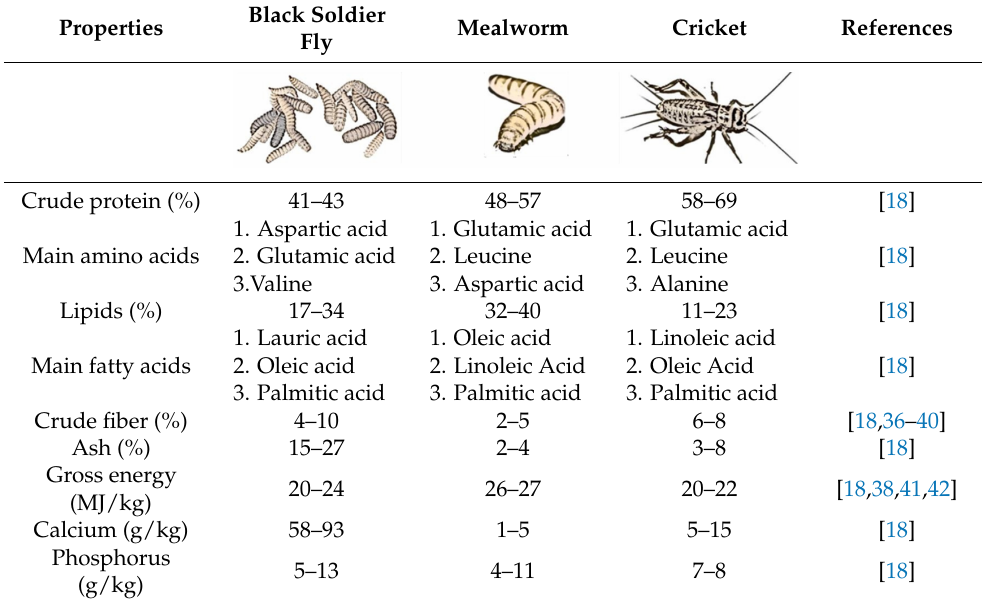
Table 1. Nutritional properties of insects used in pet